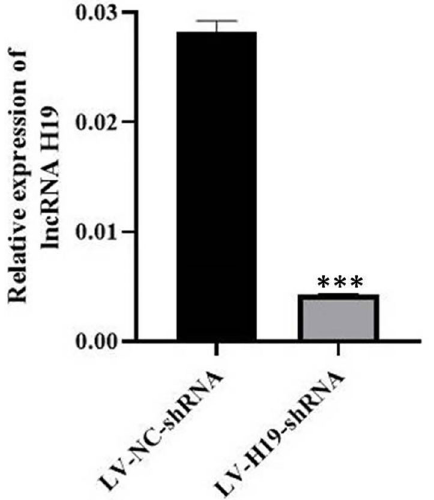
Figure 2. The knockdown ef fi ciency of LV-H19-shRNA was assessed by RT-PCR in a mouse model of endometriosis. Data are reported as means ± SD. ***P o 0.001 compared to its negative control (LV-NC-shRNA) (Student ’ s t